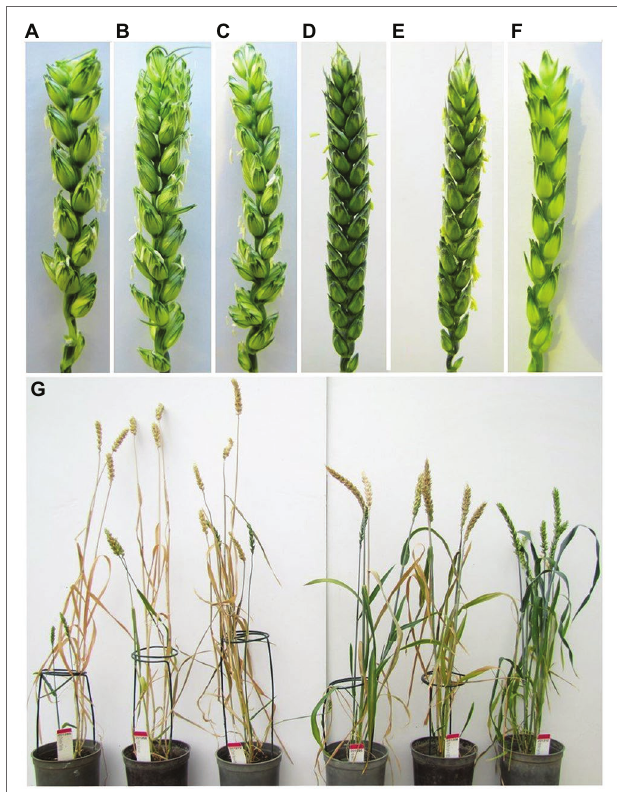
FIGURE 3 | Spike morphology of the wild-type ( Ph1 ) plants and of those carrying the ph1b deletion: (A) wild-type Chinese Spring; (B) Chinese Spring ph1b _K; (C) Chinese Spring ph1b _N; (D) wild-type Mv9kr1; (E) Mv9kr1 ph1b _K; (F) Mv9kr1 ph1b _N; (G) Whole plant morphology of the same genotypes (in the same order as it was shown for spike